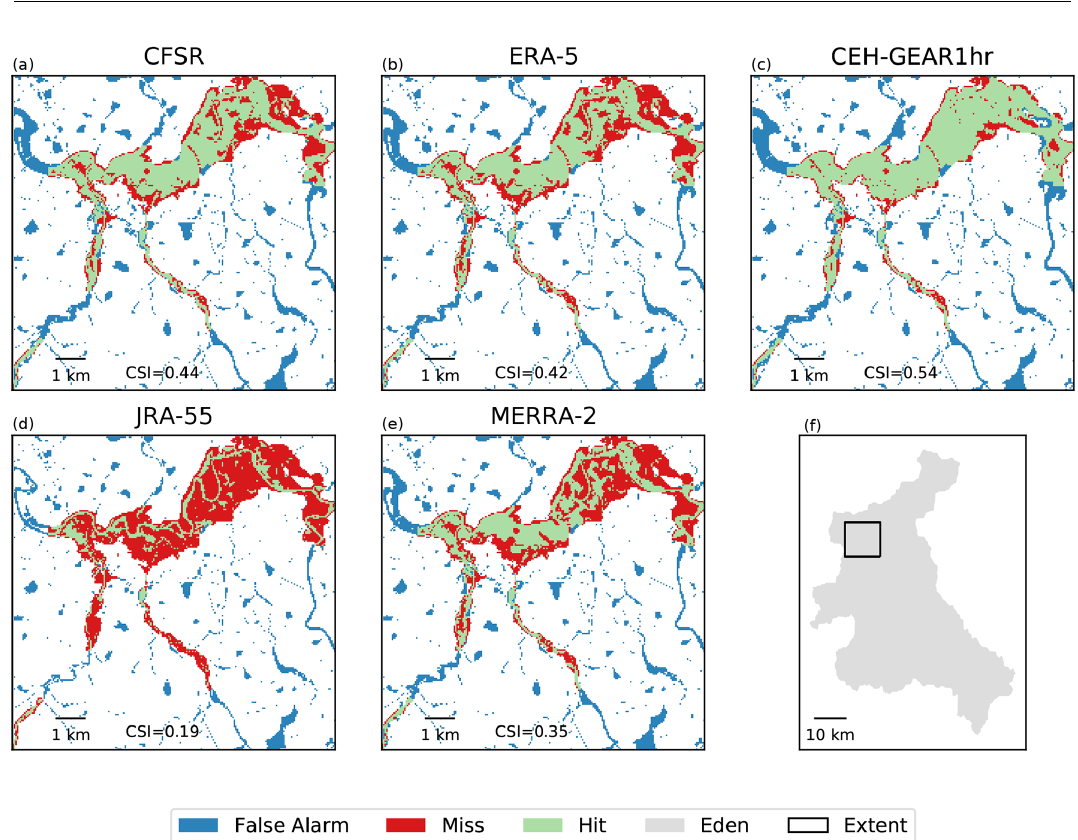
Figure 5. Comparison of flood extent based on a threshold of 0.3m with Environment Agency Recorded Flood Outlines for the 2005 event in